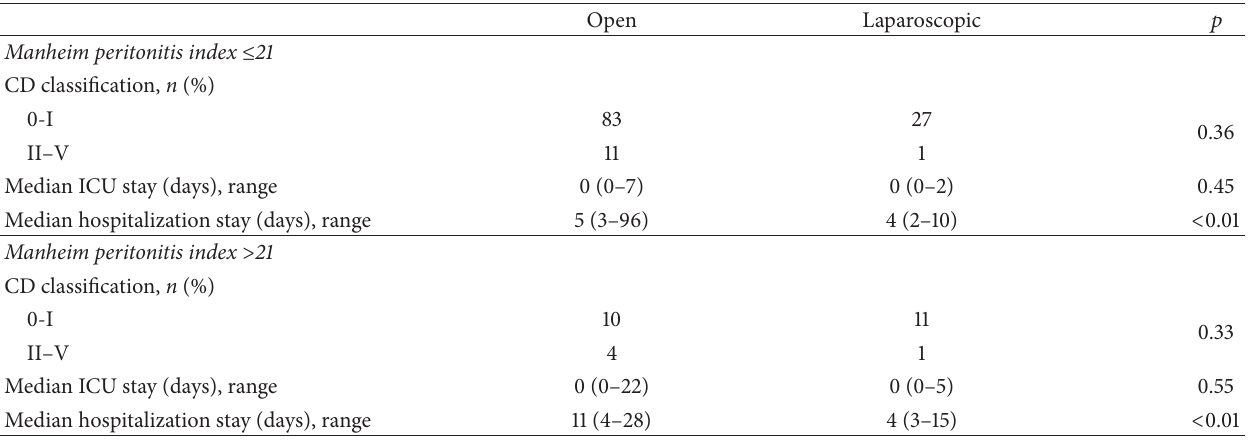
Table 3: Effects on length of stays and postoperative complications stratified by Manheim peritonitis index total score.